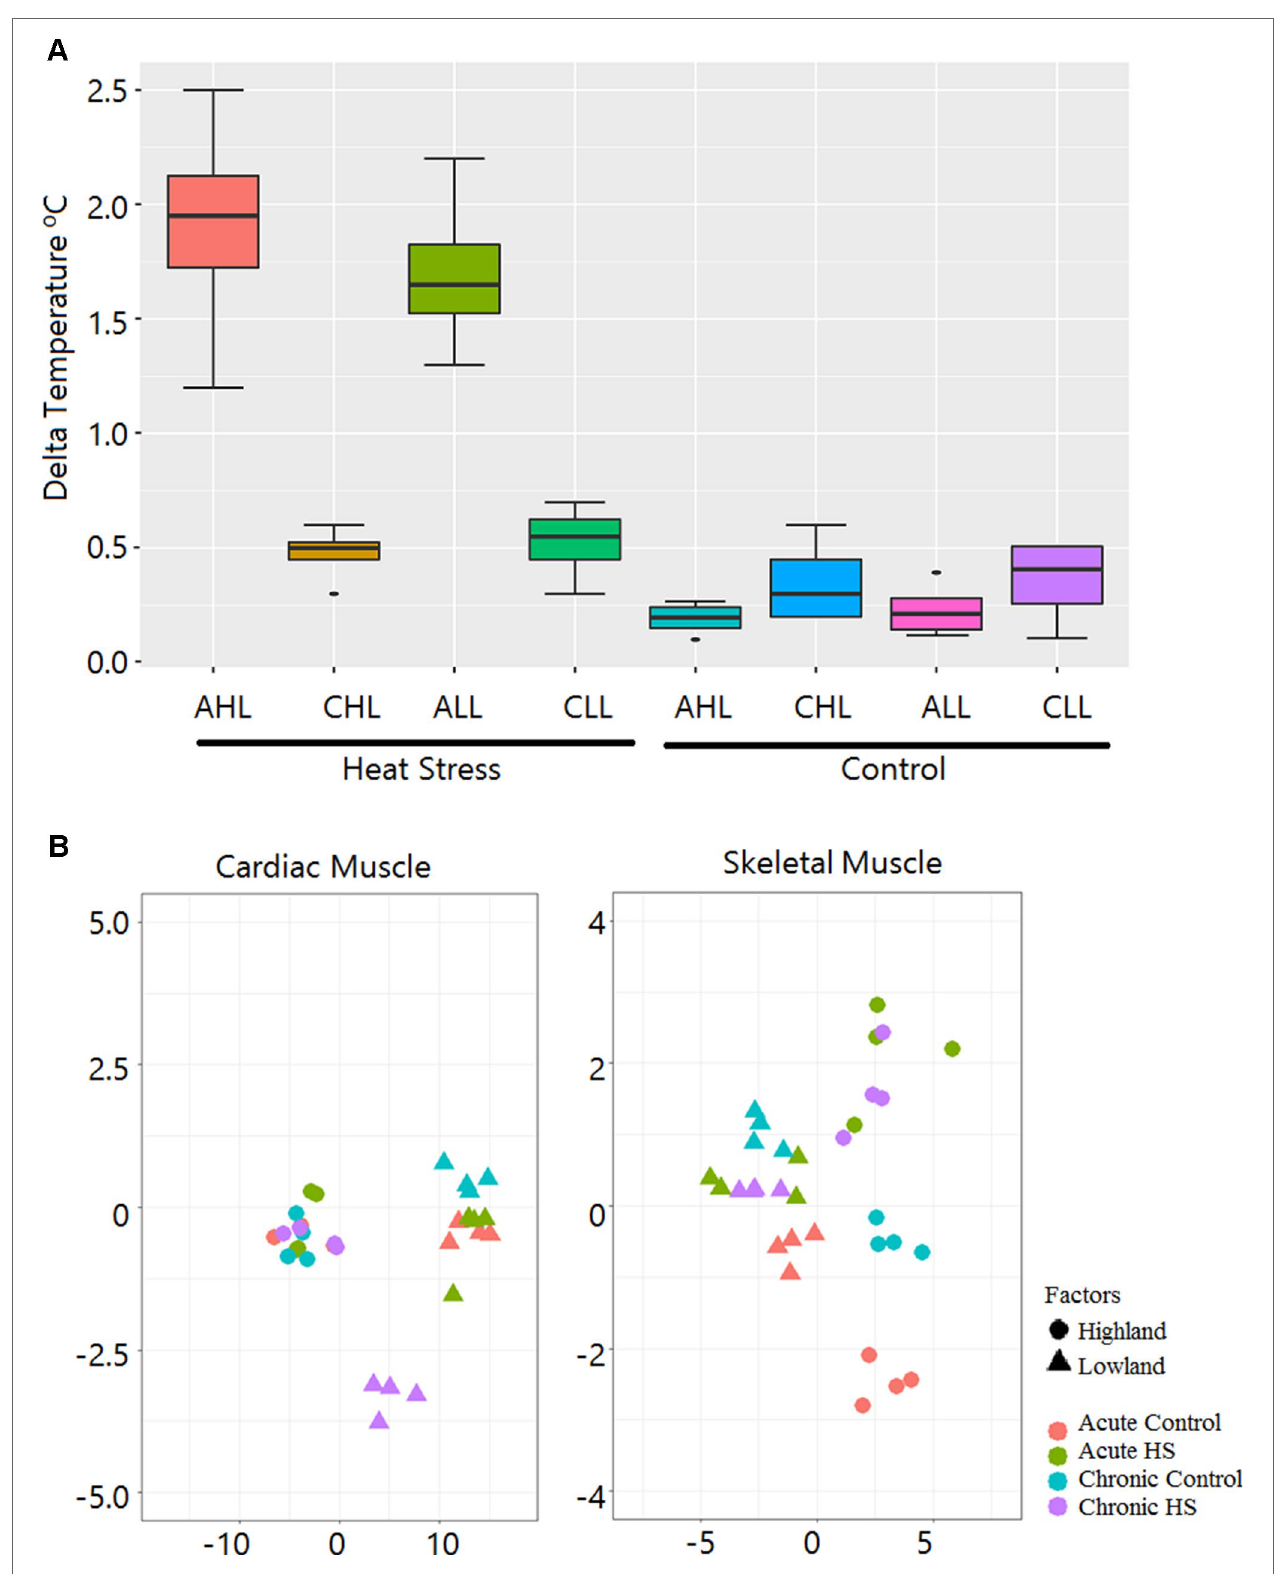
FIGURE 2 | Rectal temperature gain during HS treatment and sample relationship inferred from principal components analysis. (A) Box plot showing gain in rectal temperature due to HS treatment. AHL, acute highland; CHL, chronic highland; ALL, acute lowland; CLL, chronic lowland. (B) Principal components analysis showing that the maximum variation is due to differences between the ecotypes. Only a small percentage of the variation is due to the HS